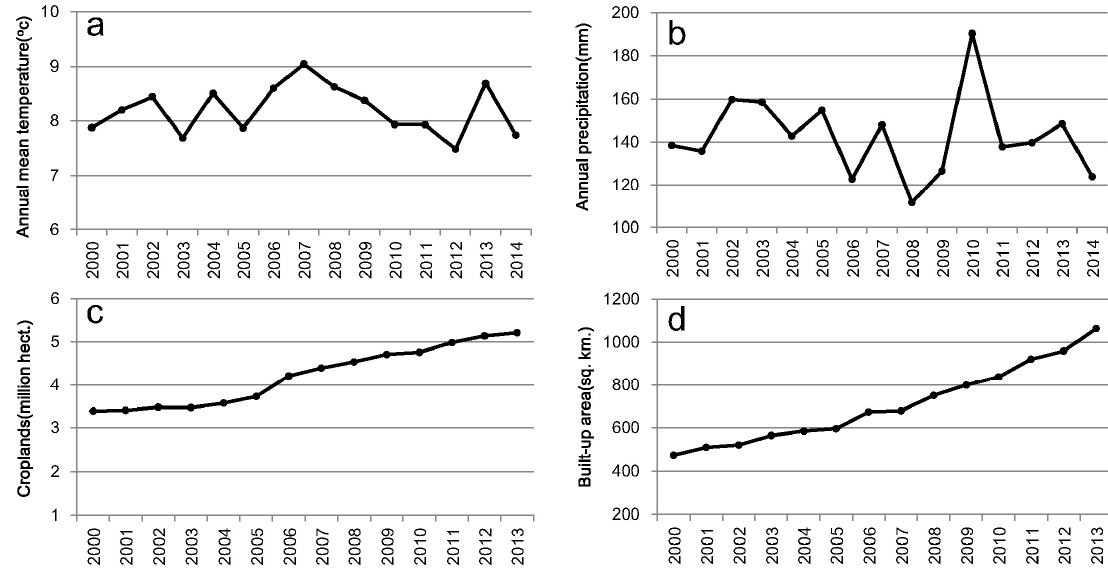
Figure 9. Variations in ( a ) annual mean temperature; ( b ) annual precipitation; ( c ) area of croplands; and ( d ) built-up areas in XUAR over the study period. Table 5. Changing trends in temperature and precipitation at meteorological stations near the major lakes from 2000 to 2014. Climate Variable Ebinur Manas Ulungur - Jili Bosten Sayram Barkol Annual Mean Temperature (°C) − 0.20 0.31 0.51 Annual Precipitation (mm) −